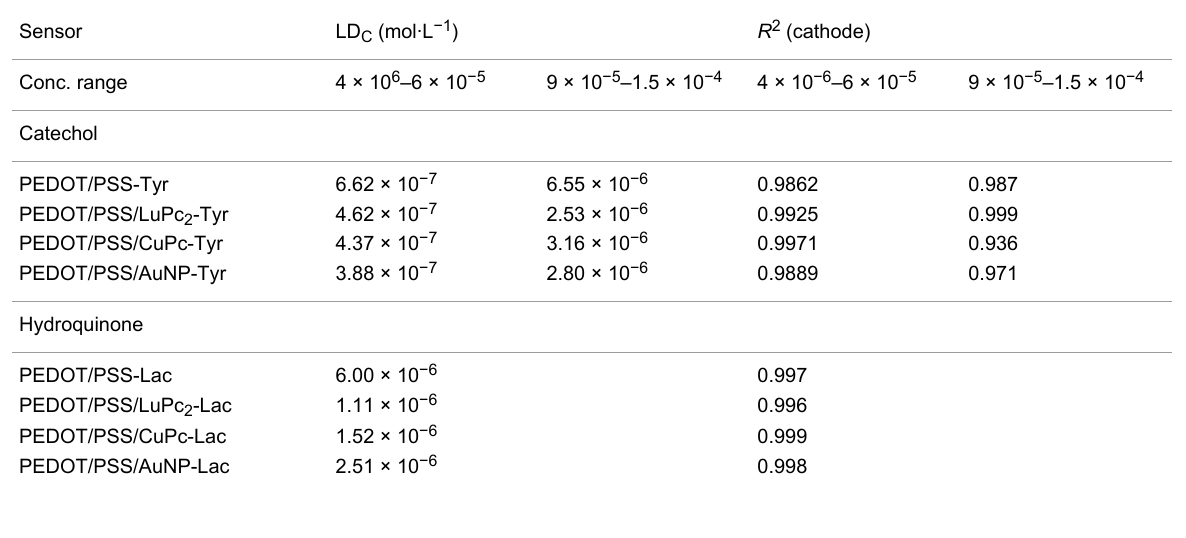
Sensor LD C (mol·L − 1 ) R 2 (cathode) Conc.